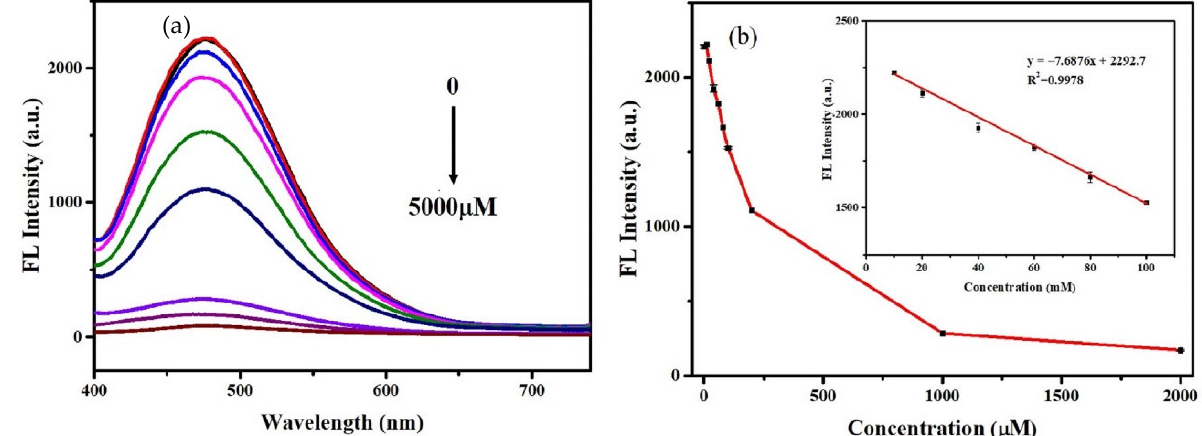
Figure 4. ( a ) Emission spectra of SQDs after adding different concentrations of Cr (VI) solution from 0 to 5 mM; ( b ) Fluorescence value of the SQDs in response to different concentrations of Cr (VI) in the range of 0 to 2 mM. Inset: the calibration curve to Cr (VI) in the linear range of 10–100 µM. The selectivity of the synthesized SQDs for Cr (VI) was evaluated. Under the same experimental conditions, 2 mM Cr (VI) and 6 mM, other interfering ions, were added into SQDs and the fluorescence intensity was measured under 380 nm excitation. As described in Figure 5, when 2 mM Cr (VI) was added to the SQDs, the fluorescence intensity of the SQDs was reduced by more than 90%. However, even when 6 mM of other common metal ions were added, the fluorescence intensity of the SQDs was not affected significantly. These data show that the SQDs have good selectivity for Cr (VI).